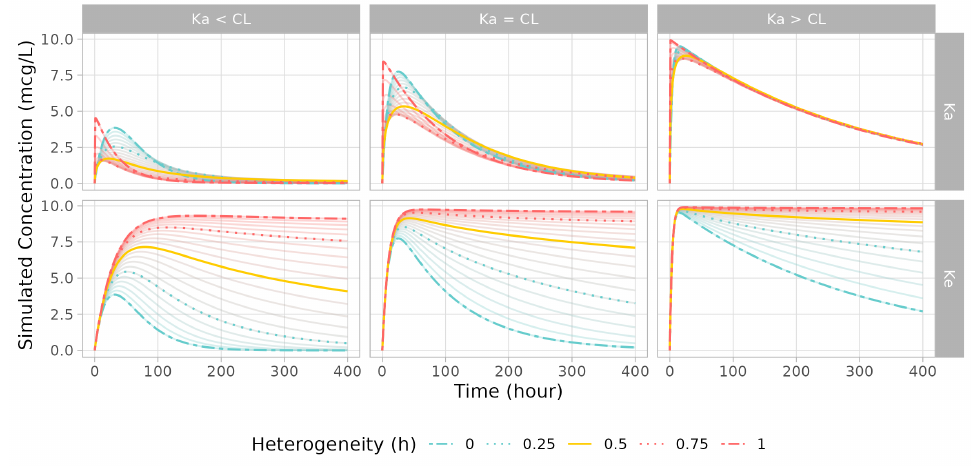
Figure 2. Simulated PK profiles of one-compartment model from parameter sets (upper label) and fractal rate (right label). Changes in the fractal exponent are plotted from 0 (blue line) to 1 (red line) by 0.05. The exponent of 0.25/0.75 is shown with dashed orange lines, and 0.5 is plotted as solid orange line.